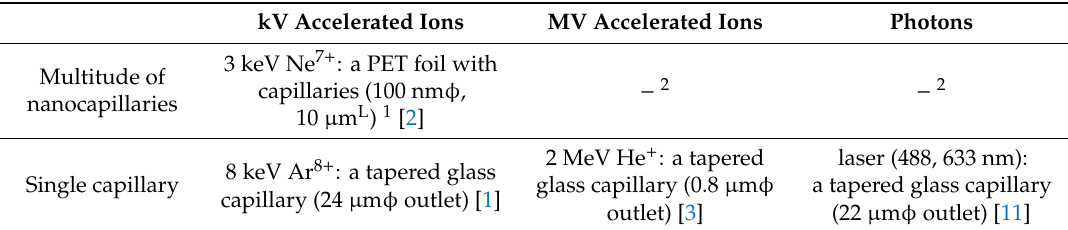
Table 1. Examples of transmission experiments using